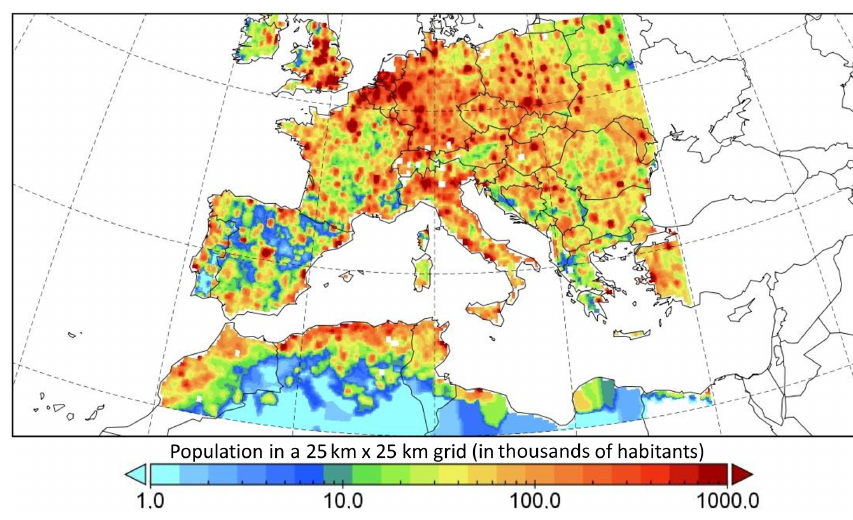
Figure 1. Population in each grid cell (in thousands of habitants) (SEDAC population dataset for 2005). Table 1. Pathology, exposure–response coefficients and economic valuation, taken from Brandt et al. (2013a). YOLL represents years of life lost. SOMO35 represents the sum of means over